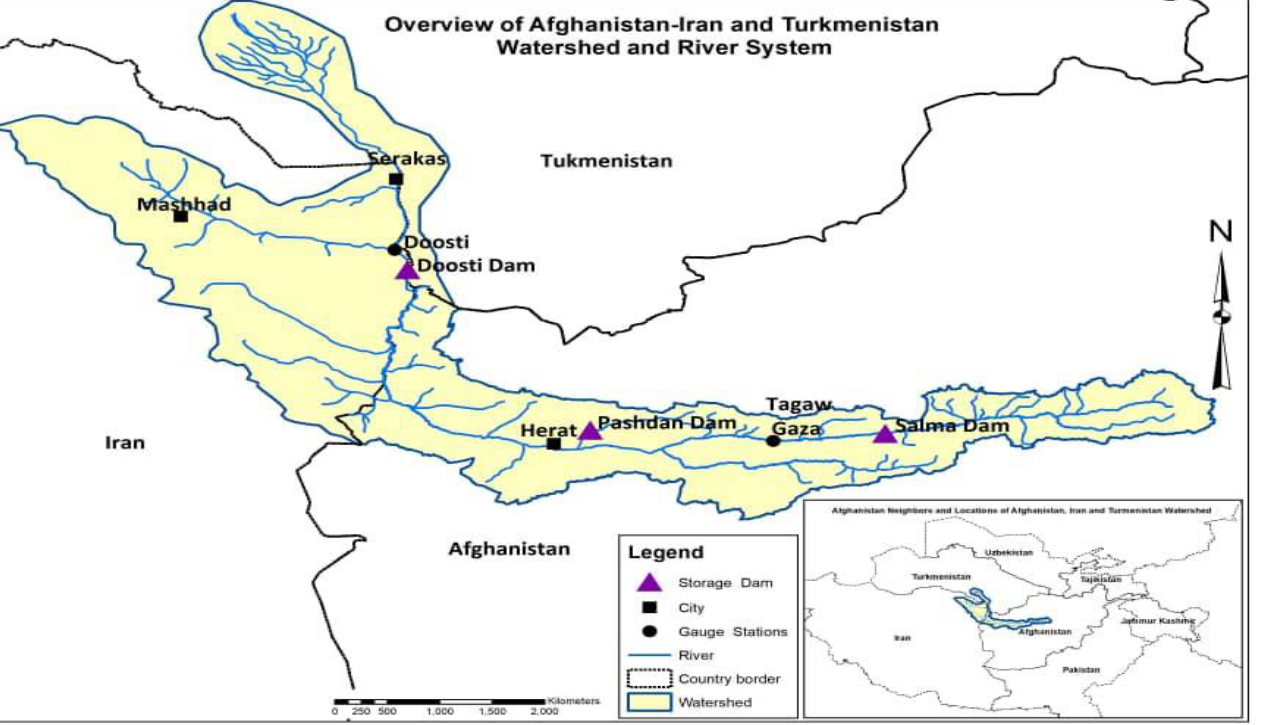
Figure 1. Location of dams in upstream and downstream of Harirud River Basin.